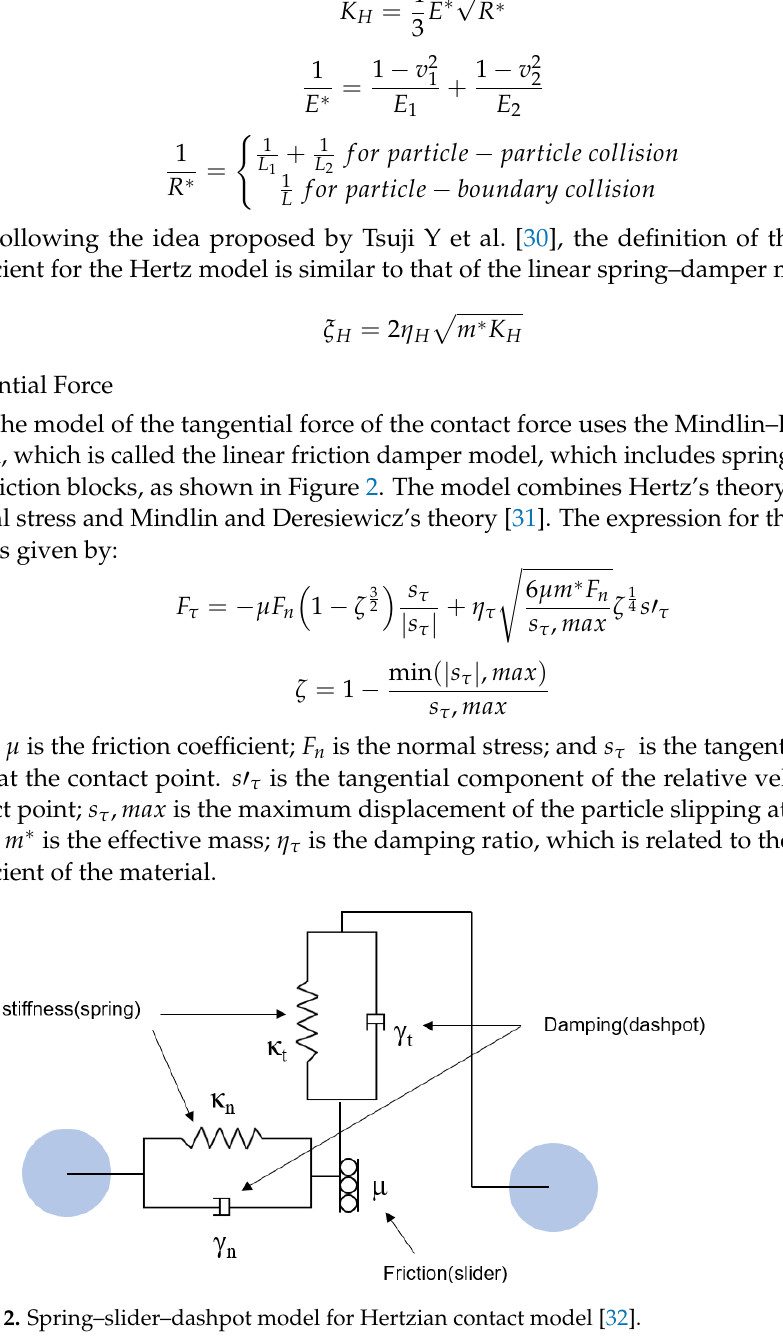
Figure 2. Spring – slider – dashpot model for Hertzian contact model [32]. Figure 2. Spring–slider–dashpot model for Hertzian contact model